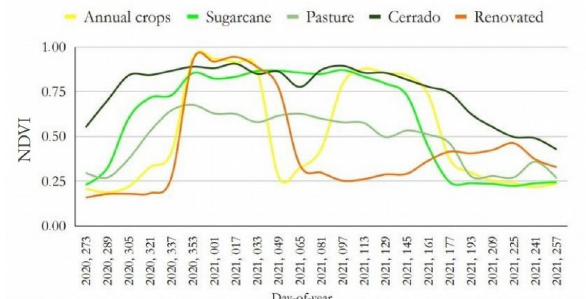
Figure 2 . Representative temporal profile of the MODIS NDVI for each LULC class of the Santa Barbara watershed, Goiás State, over the 2020−2021 season. X-axis corresponds to the Julian